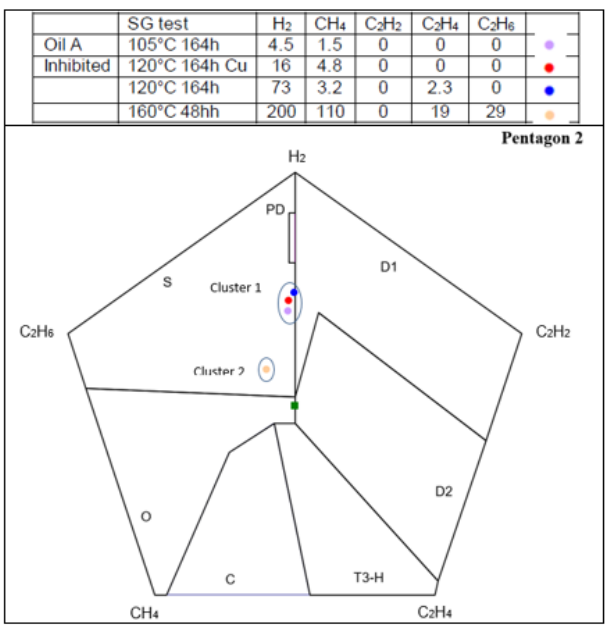
Figure 1. Stray gassing (SG) of inhibited mineral oil A during laboratory tests at the High Voltage Testing and Engineering Commission of Switzerland (FKH), in Clusters 1 and 2.